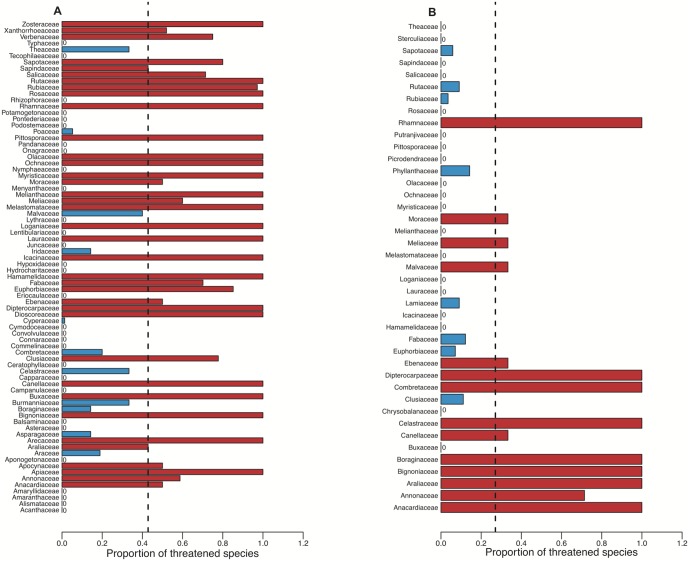
Taxonomic distribution of extinction risk.A) Patterns within red-listed flora of Tanzania; B) Patterns within Eastern Arc. Proportion of threatened was assessed as number of threatened species in a family divided by the total number of species assessed within that family. Families with higher than expected proportions of threatened species are shown in red, and families with significantly lower proportions of threatened species are shown in blue. The dashed line represents the mean proportion of threatened species across all families.